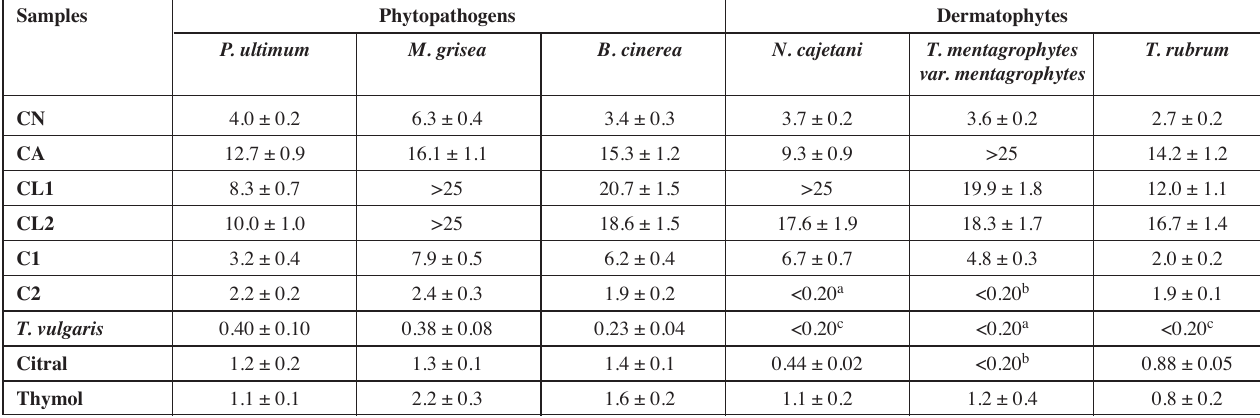
Tab. 4: Antifungal activity of Citrus spp. petitgrains compared to commercial T. vulgaris essential oil, citral and thymol.